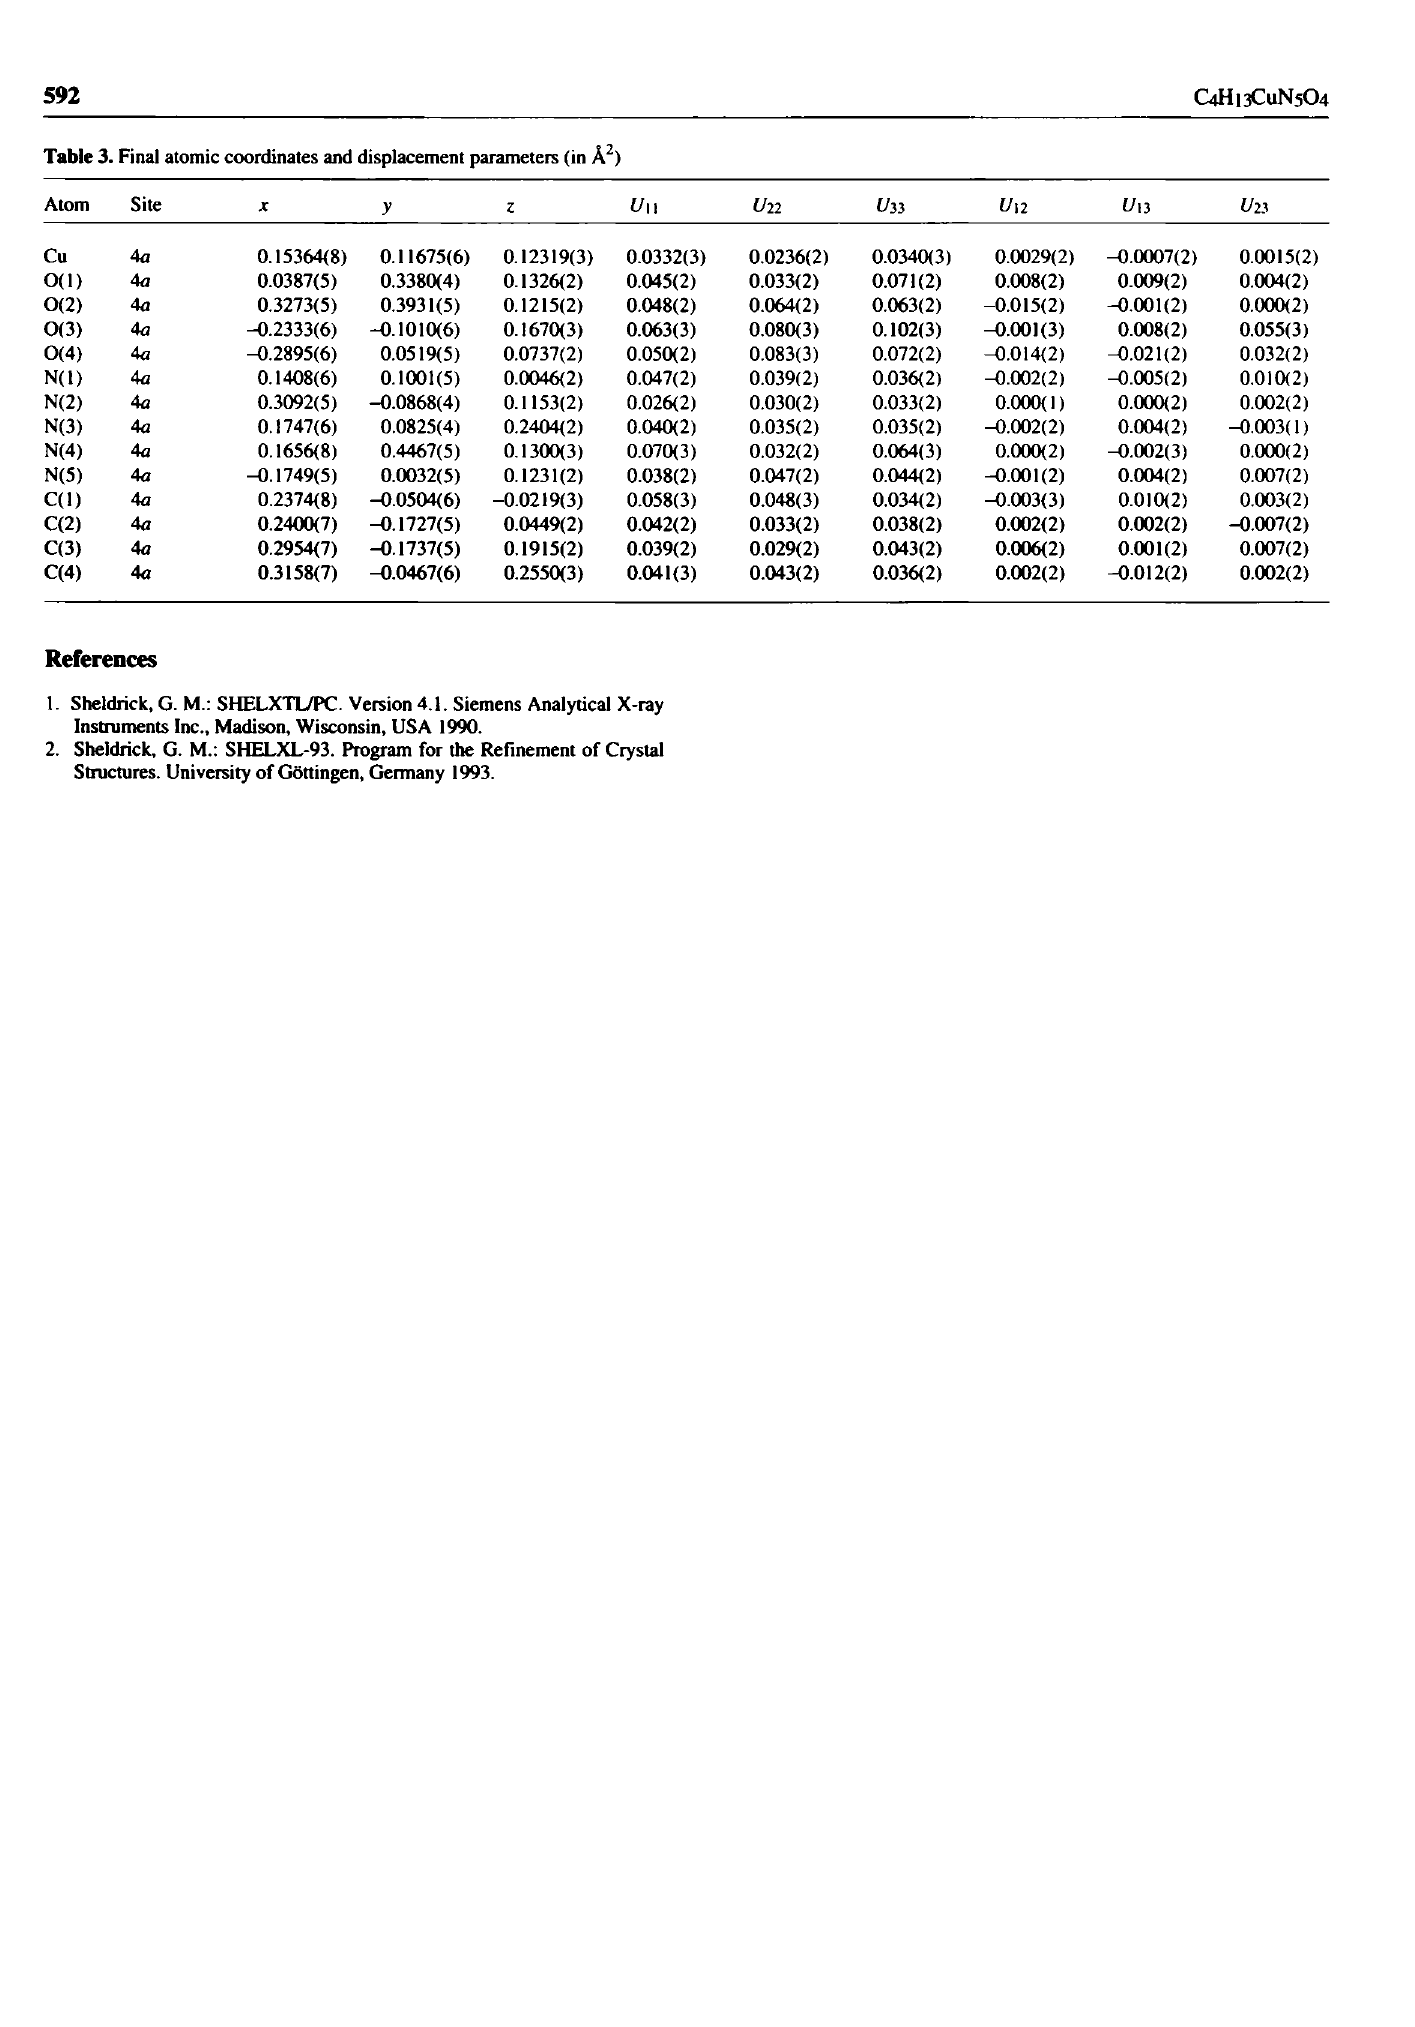
Table 3. Final atomic coordinates and displacement parameters (in Â^)